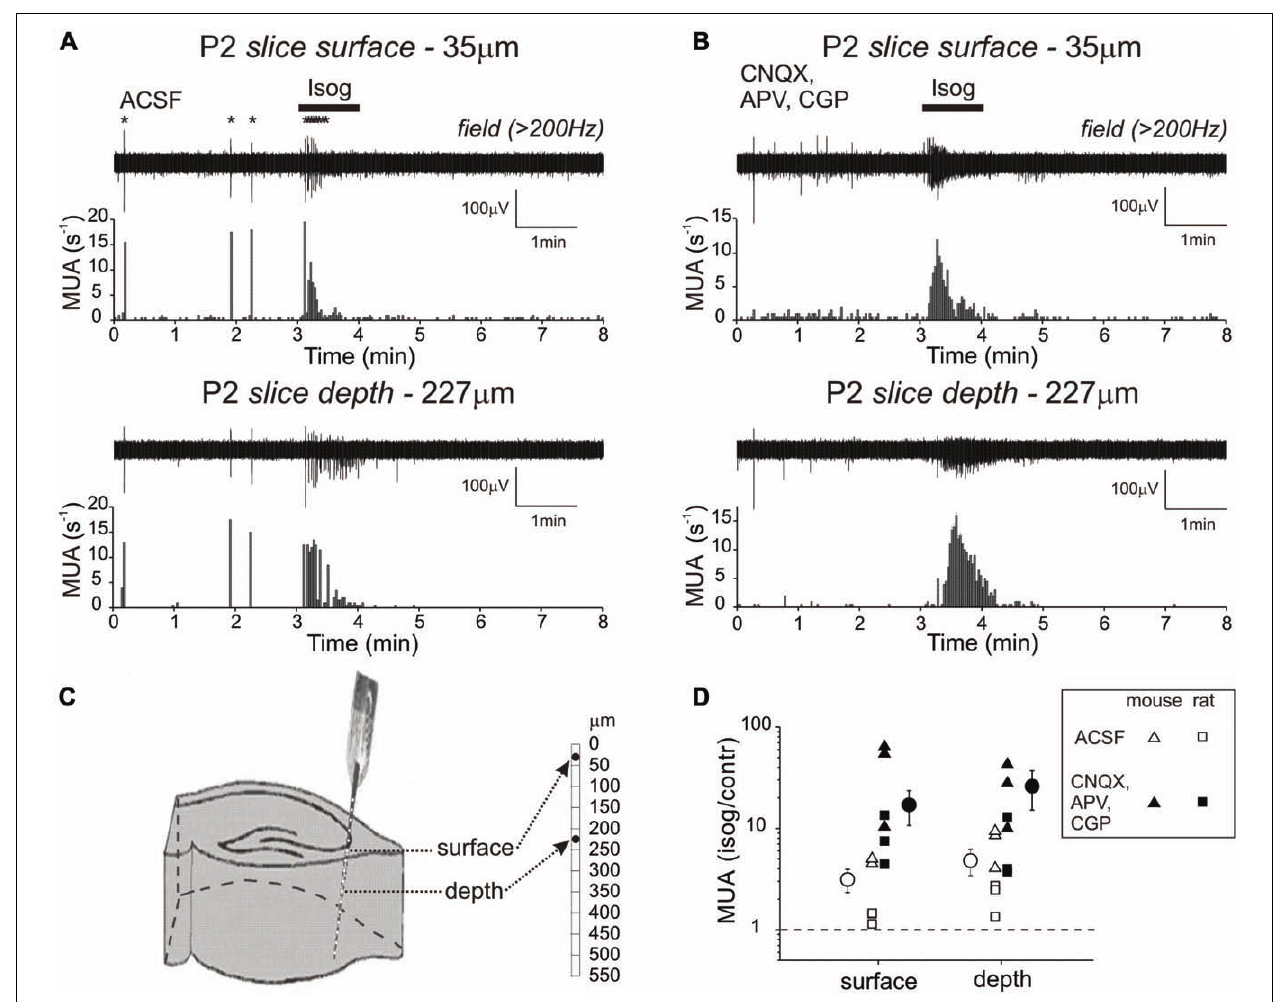
deep electrodes of the 16 site silicone probe in control conditions (A) and in the presence of glutamate and GABA(B) receptor antagonists (CNQX, APV, CGP55845) (B) . (D) Summary plot of MUA response on isoguvacine application, normalized to control level of activity in ACSF (open symbols) and in the presence of CNQX, APV, CGP55845 (closed symbols). Each data point corresponds to an individual intact hippocampus. Mean values are shown by the circles with error bars indicating